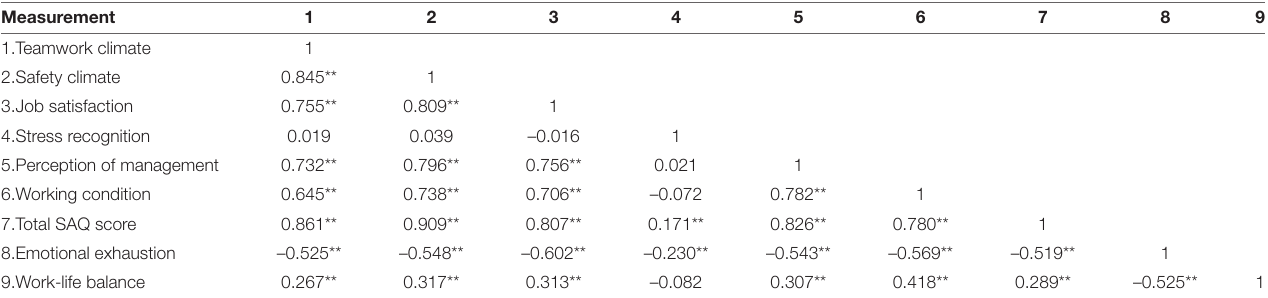
TABLE 5 | Correlations matrix among dimensions of SAQ, EE, and WLB.